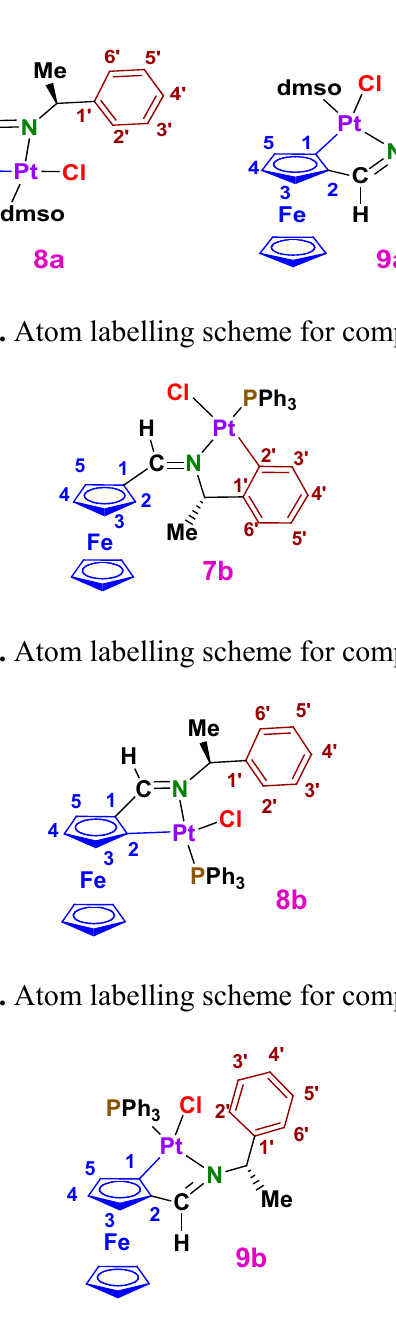
Figure A3. Atom labelling scheme for diastereomers 8a and 9a .